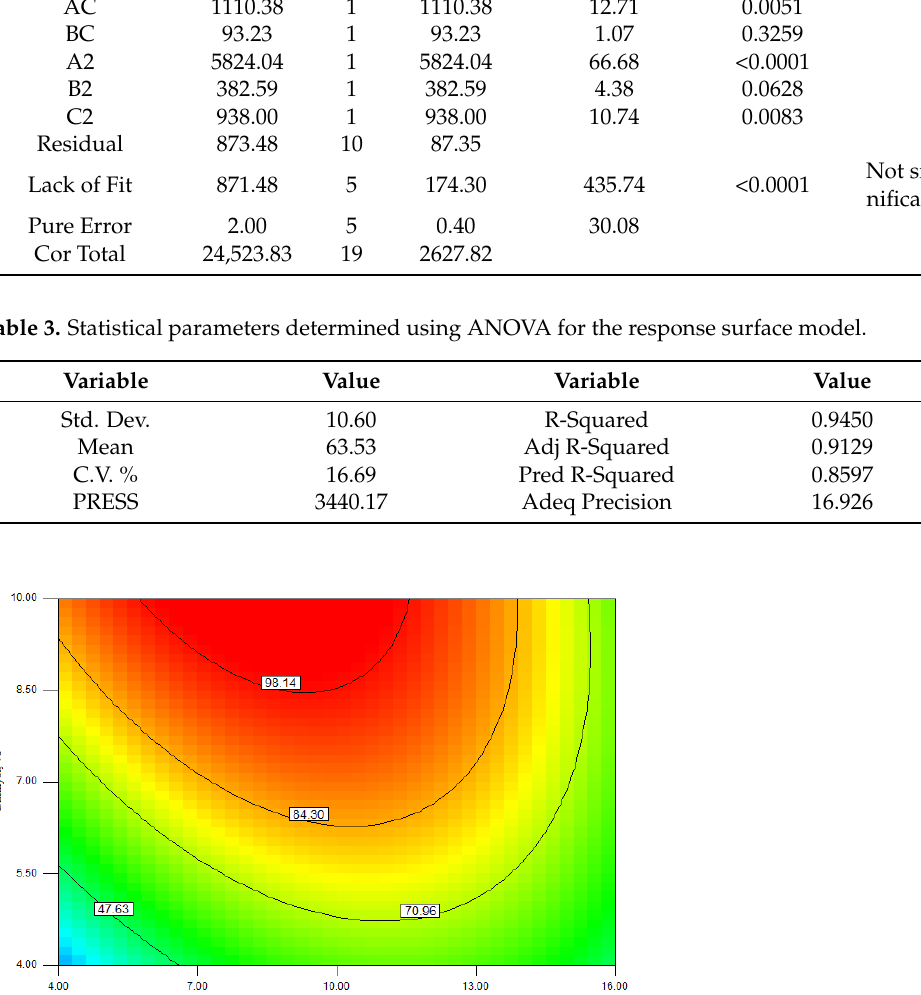
Table 3. Statistical parameters determined using ANOVA for the response surface model.